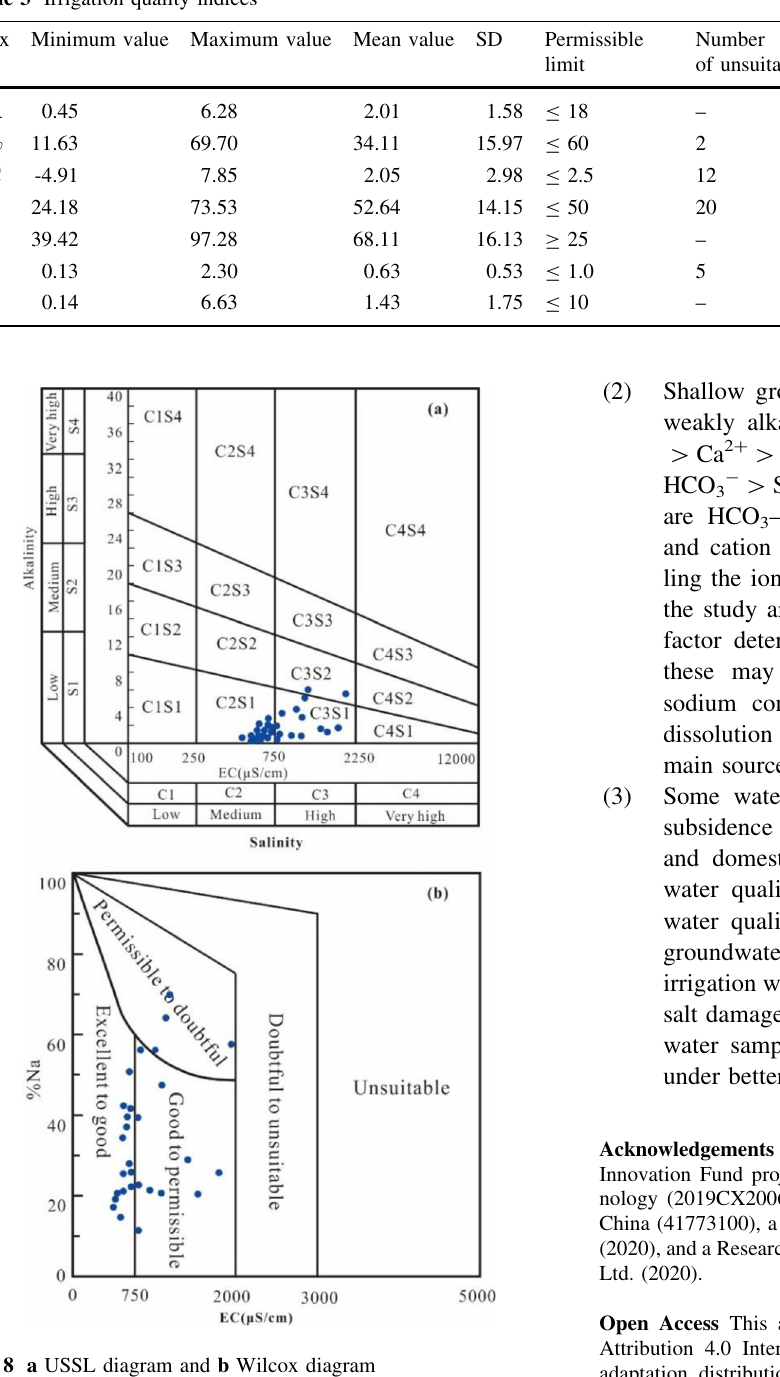
Fig. 8 a USSL diagram and b Wilcox